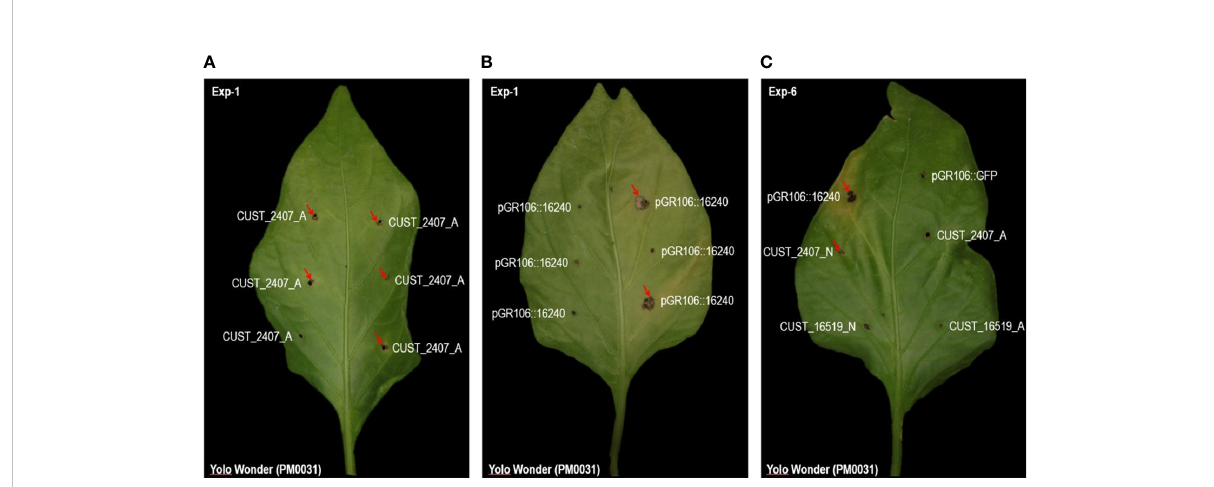
FIGURE 6 Up-side of host S leaves agro-infected by the RxLR constructs and the control constructs in Exp-1 and Exp-6 experiments. In Exp-1, four leaves of each pepper accession were agro-infected at six points per leaf with a single construction. In Exp-6, 18 or 19 leaves of each accession were agro-infected with four RxLR constructs and two controls separately on each leaf. Exp-6 thus consisted to agro-infect each RxLR construct with the positive and negative controls on the same leaf. Constructs pGR106::GFP and pGR106::16240 were used as negative and positive controls, respectively. The 460 agro-infected points performed on the eleven pepper accessions with the negative control produced no hypersensitive response (HR). The 464 agro-infected points performed on the eleven pepper accessions with the positive control yielded an average of 36,4% HR. The four other four constructs corresponded to the RxLR genes CUST_2407 and CUST_16519 isolated from isolates A and N. The host accession is Yolo Wonder (PM0031), susceptible to Phytophthora capsici . Red arrows indicate the dark local necrosis observed around the agro-infection point, scored as a HR. (A, B) illustrate the quantitative ef fi ciency of transient in planta expression of CUST_2407_A and pGR106::16240, respectively, justifying the need for multiple agro-infection points per construct. (C) illustrates the consistency between Exp-1 and Exp-6 experiments, as shown here for the RxLR CUST_2407_A and the control pGR106::GFP, and as reported in Supplementary Table S9. Photographs were taken at 20 days after